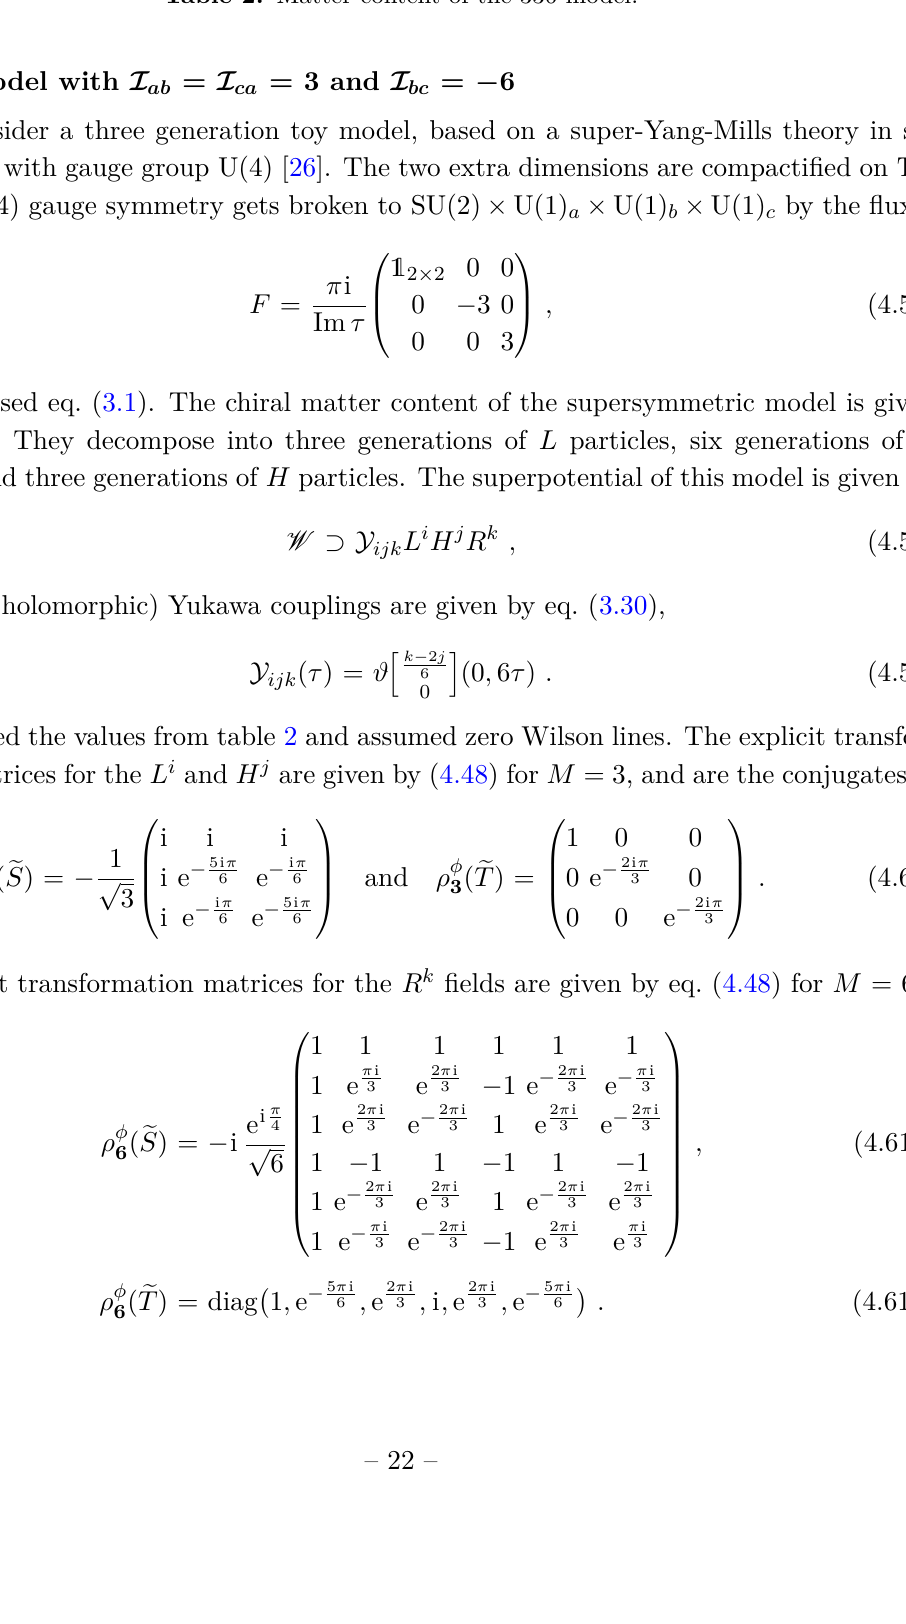
Table 2. Matter content of the 336